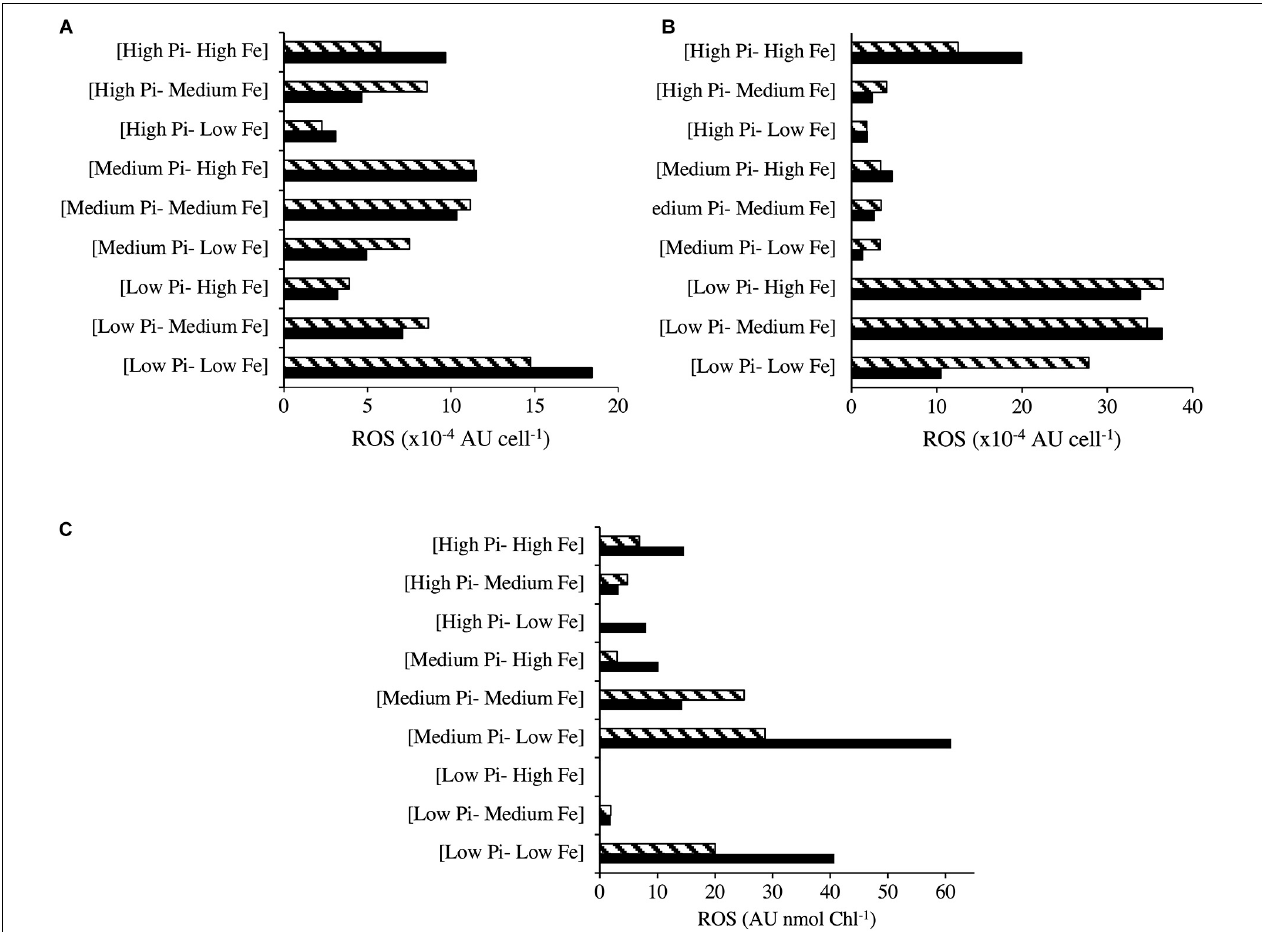
FIGURE 6 | Radical oxygen species (ROS) production at different combinations of PO 43 − and Fe concentrations for Halothece sp. under (A) NO 3 − optimal and (B) [Low NO 3 − ] conditions and (C) for F. muscicola . PO 43 − is represented as Pi. Data presented are actual values of the duplicates (striped and solid